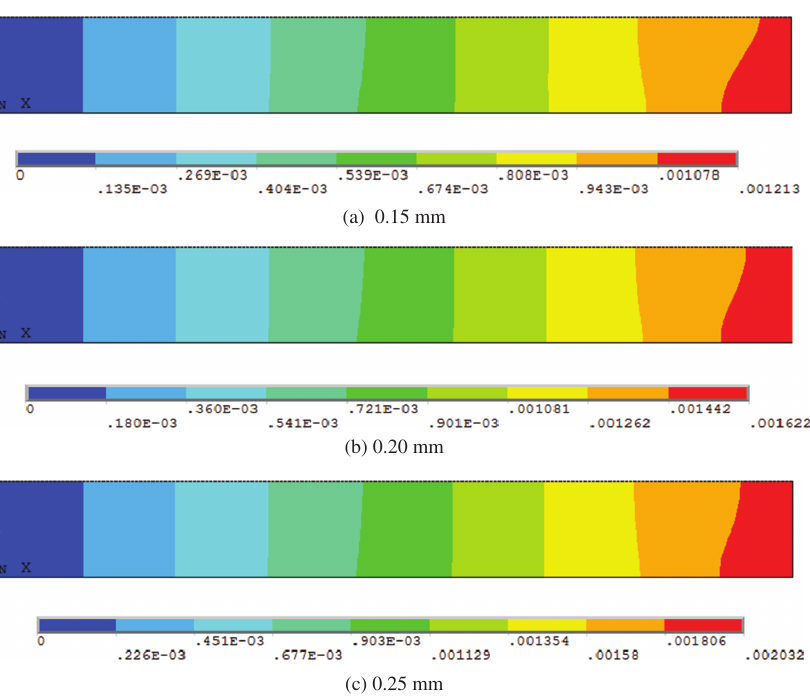
Figure 2: Displacement nephogram along width direction of slab under different reduction amounts.